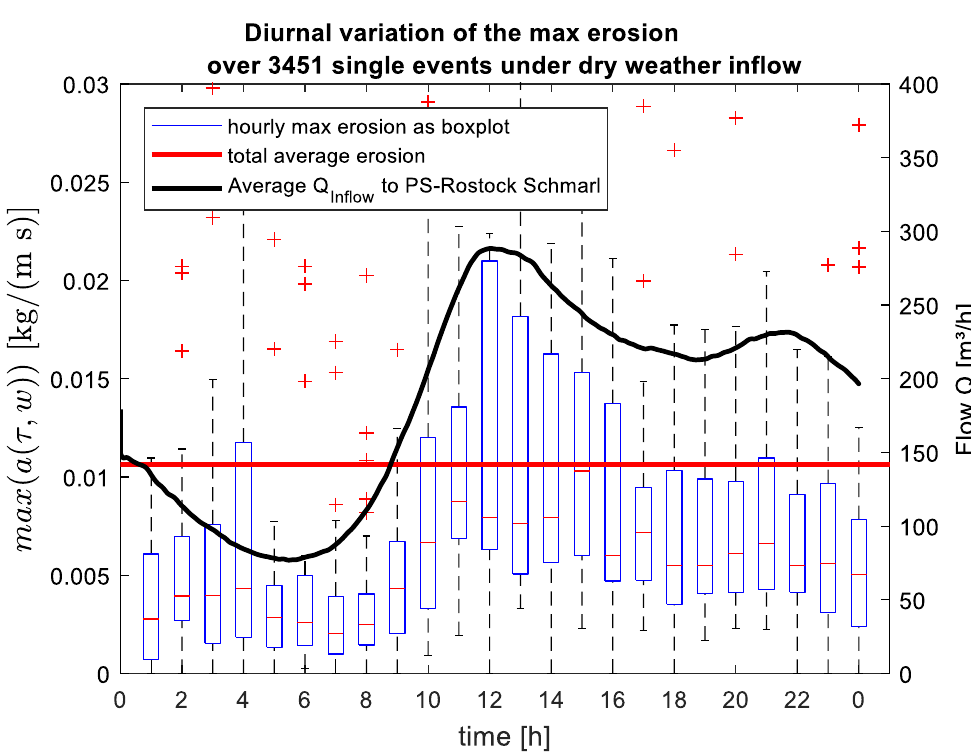
Figure 9. Diurnal variation of the max erosion (boxplots) including total average erosion over 3451 single erosion events (red line) and the average Q inflow for dry weather conditions (black line).